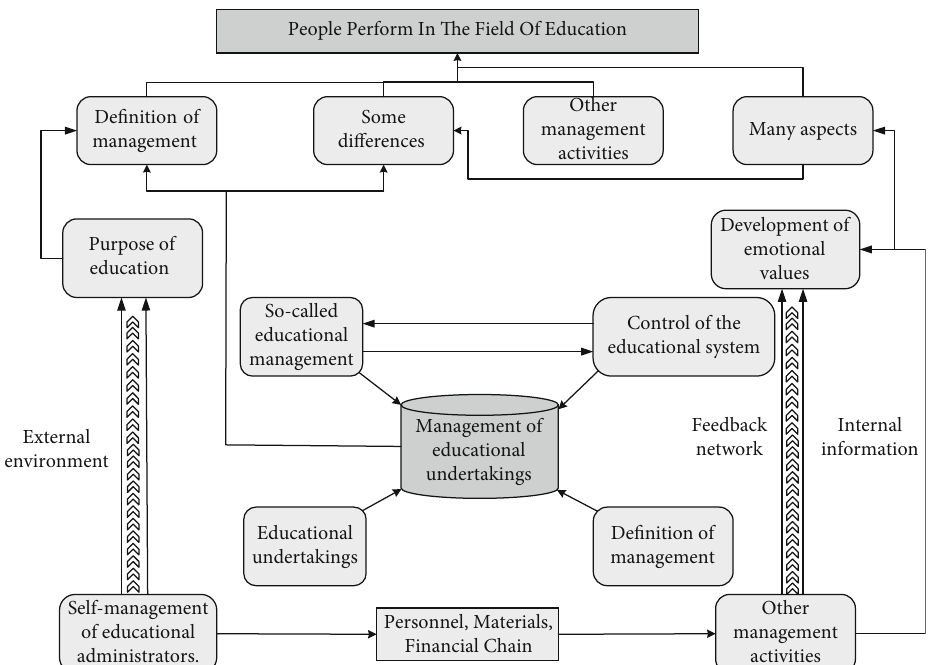
Figure 1: System management theory model